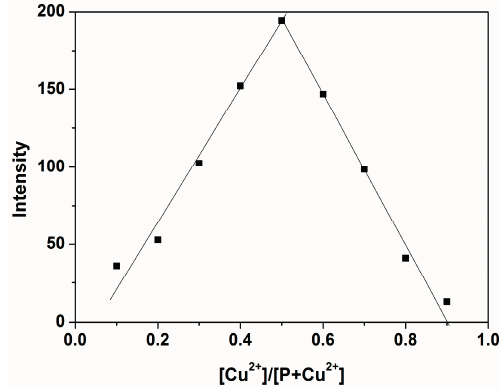
Figure 5. Job’s plot of P with Cu 2+ . The total concentration of P and Cu 2+ was kept at a fixed 50